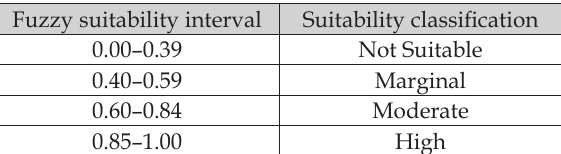
Table 2. Weights use for calculating corn suitability based on